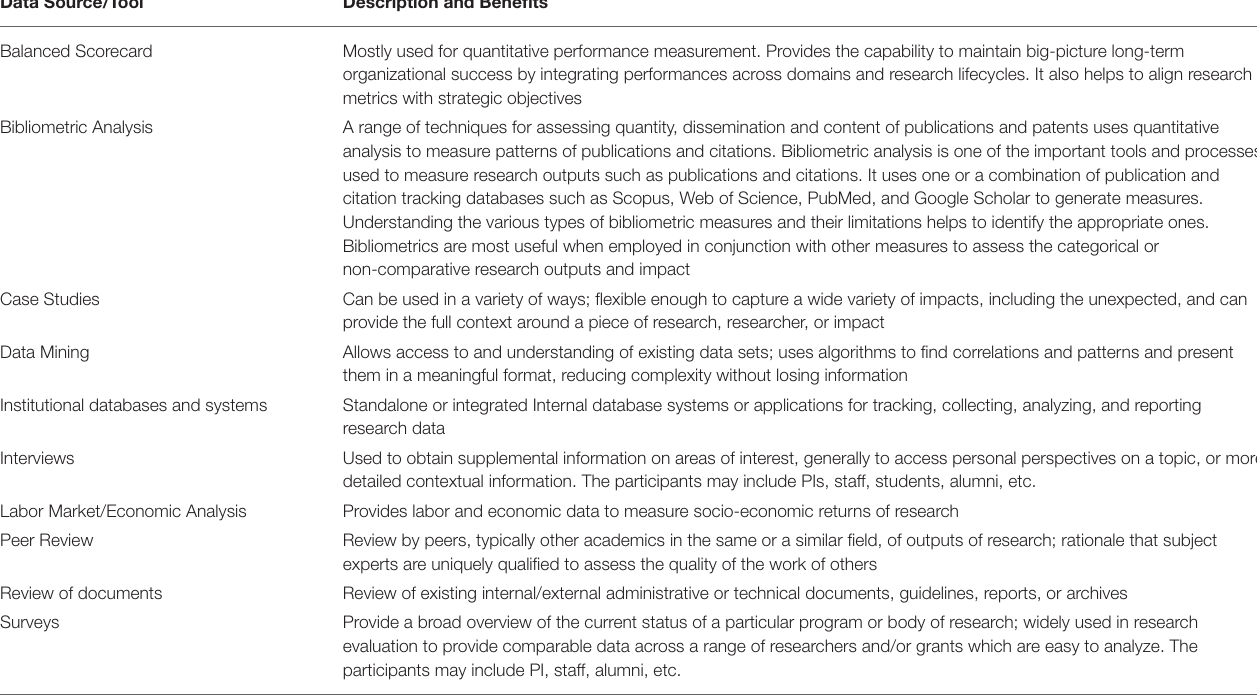
TABLE 4 | Examples of research measurement